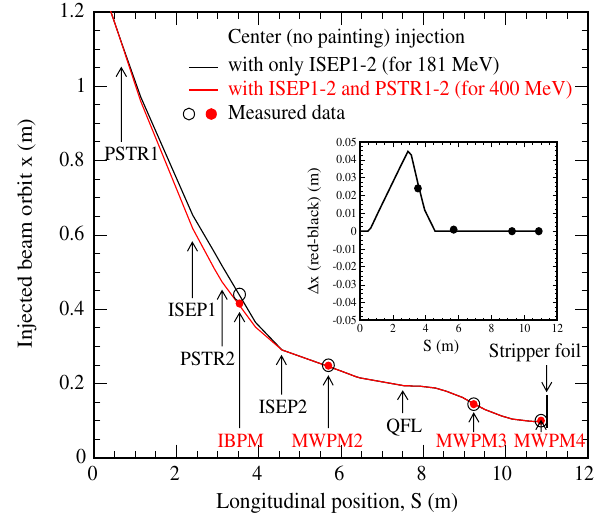
FIG. 8. Calculated injected beam trajectories (lines) and mea- sured beam positions (symbols) at four locations are shown for the center injection. The black line and the black open circles are for the present 181 MeV injected beam, while red lines and red solid circles are for an equivalent center injection trajectory for the 400 MeV injected beam. ISEP1-2 are only used for the 181 MeV while PSTR1-2 in addition to the ISEP1-2 are used for the equivalent center injection orbit at the 400 MeV. A difference of the two orbits is shown in the inset. A good consistency between expected and measured data has also been demonstrated here.